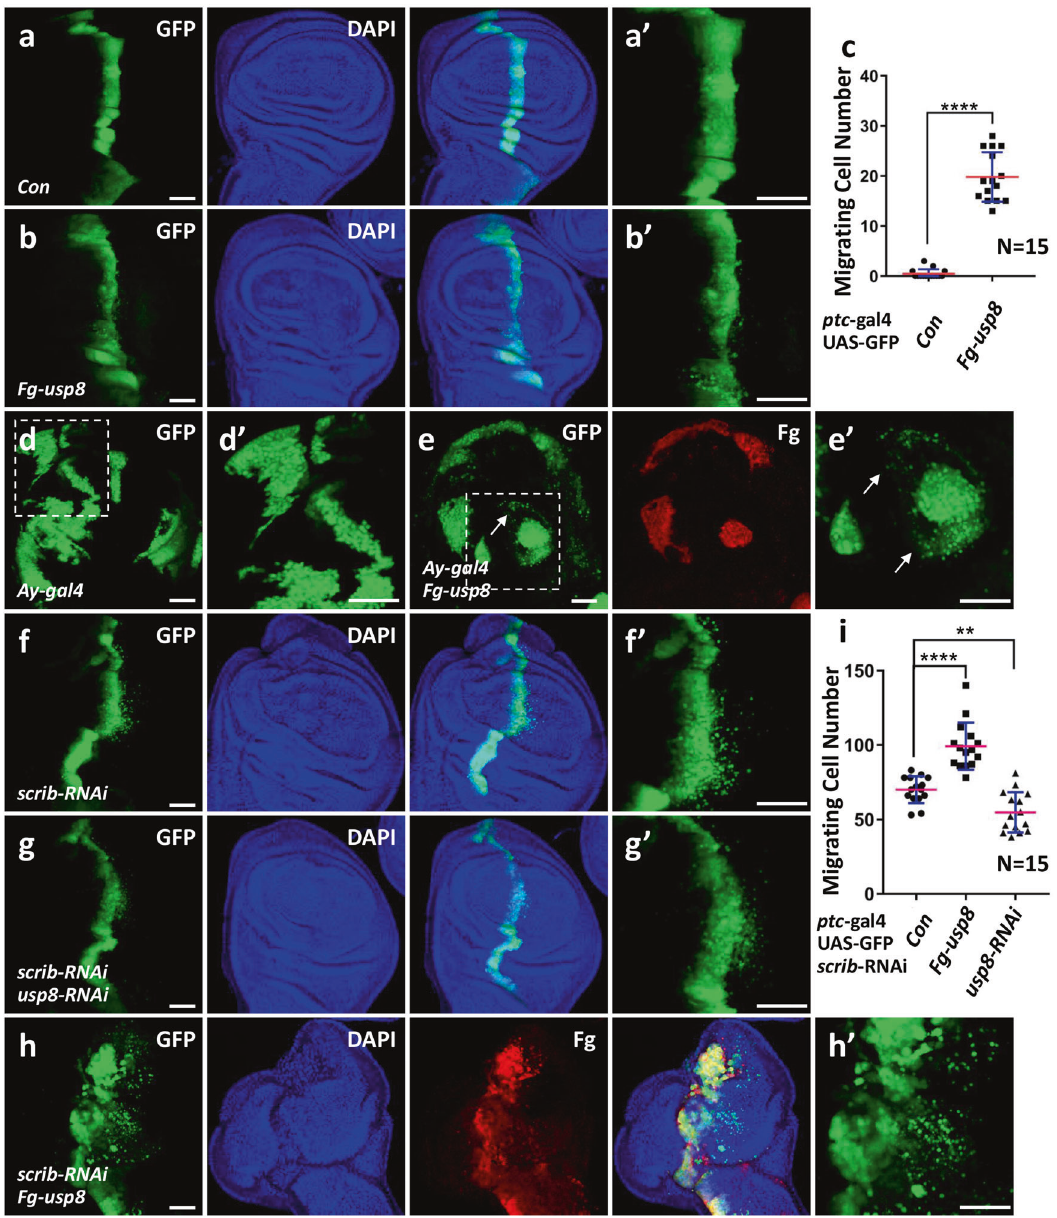
Fig. 1 Ectopic expression of Usp8 induces cell migration. a The third-instar larvae wing disc of ptc -gal4 was used as a control, a' was an enlarged fi gure of a . b Overexpression of usp8 driven by ptc -gal4 induced cell migration from A/P boundary to posterior. GFP (green) marks the expression regions of ptc -gal4 in the wing disc. c Quanti fi cation analyses of migrating cell numbers in a, b ( N = 15). d A control wing disc expressing GFP using FLP-out technique was stained with GFP (green). e Ectopic expression of usp8 in the wing disc through FLP-out technique triggered cell migration (arrows). f Knockdown of scrib in the wing disc induced cell migration. g Knockdown of usp8 suppressed scrib -RNAi-induced cell migration. h Overexpression of usp8 promoted scrib -RNAi-induced cell migration. i Quanti fi cation analyses of migrating cell numbers in f – h ( N = 15). All wing imaginal discs shown in this study were oriented with anterior on the left and ventral on the top. The t -test was used for statistical analyses, ** p < 0.01; **** p < 0.0001. Scale bars: 50 μ m for all disc Tak1, two truncated constructs were used to express the N-terminus (Tak1-N) and C-terminus (Tak1-C) of Tak1, respectively (Fig. 4b). Co-IP and GST pull-down assays revealed that Tak1-N could bind Usp8, while Tak1-C failed to do (Fig. 4h, i). Usp8 deubiquitinates and stabilizes Tak1 The interaction between Usp8 and Tak1 prompted us to examine whether Tak1 is a substrate of Usp8. First, we used the translation inhibitor cycloheximide (CHX) to block protein synthesis and determine the stability of Tak1 with or without Usp8 co-expression.